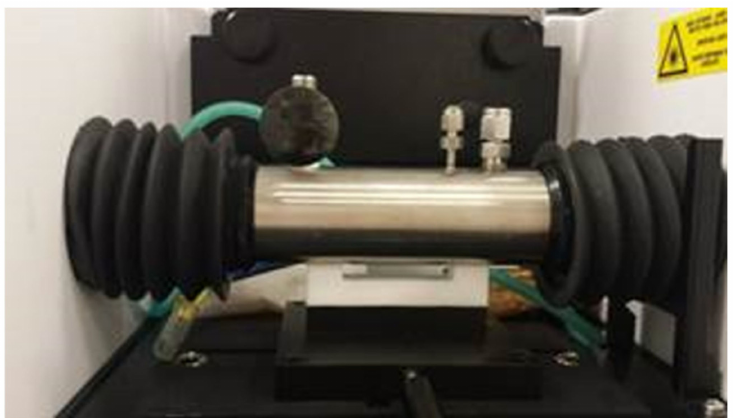
Figure A1. Gas cell used for gas-phase FTIR